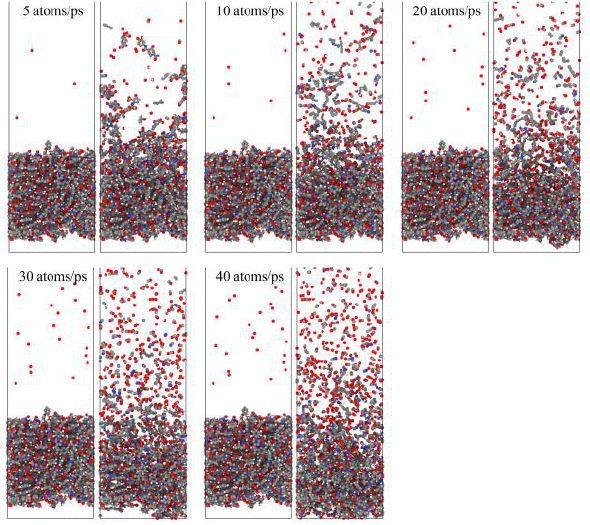
Figure 23. Snapshots of AO impacting Kapton at different dose rates during the initial phase (0.6 ps) and the termination phase (30 ps).